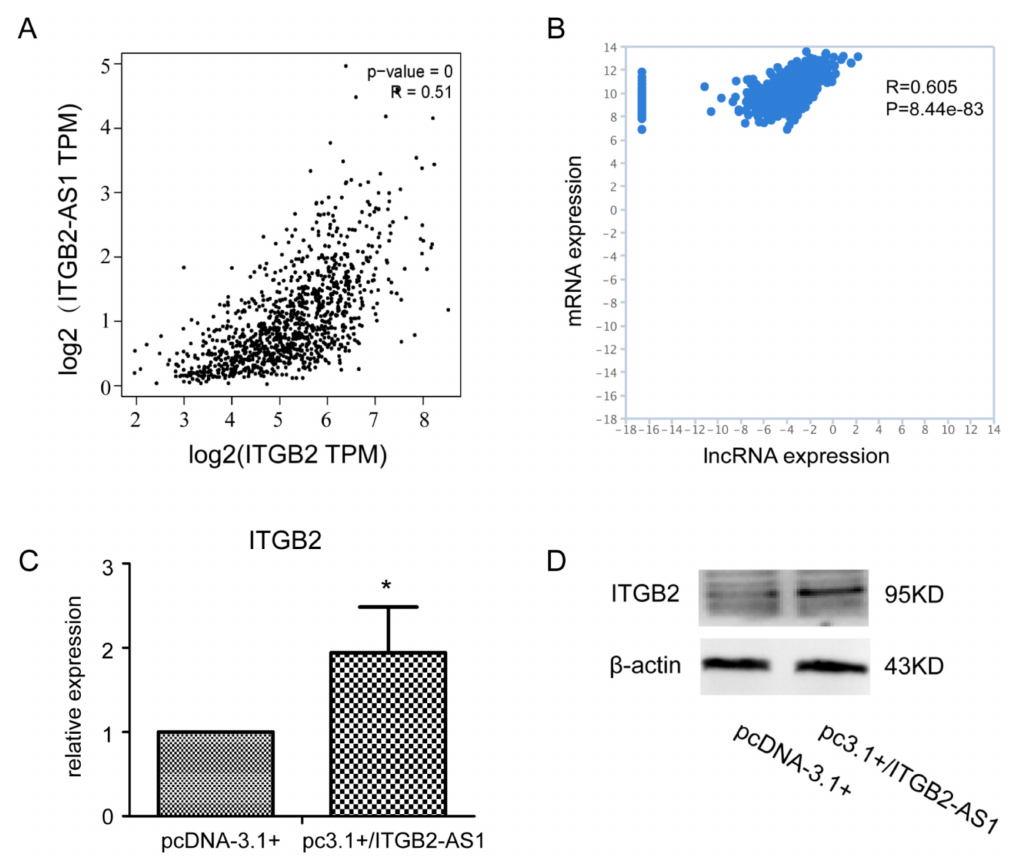
Figure 4. There is a positive correlation between the expression of ITGB2-AS1 and ITGB2. ( A ) The correlation between ITGB2-AS1 and ITGB2 in GEPIA website; ( B ) The correlation between ITGB2-AS1 and ITGB2 in TANRIC website; ( C ) Q-PCR assay in MCF-7 cell; the β -actin was used as internal reference; ( D ) The ITGB2 protein expression was determined by western blotting in MCF-7 cell. * p < 0.05 vs. control